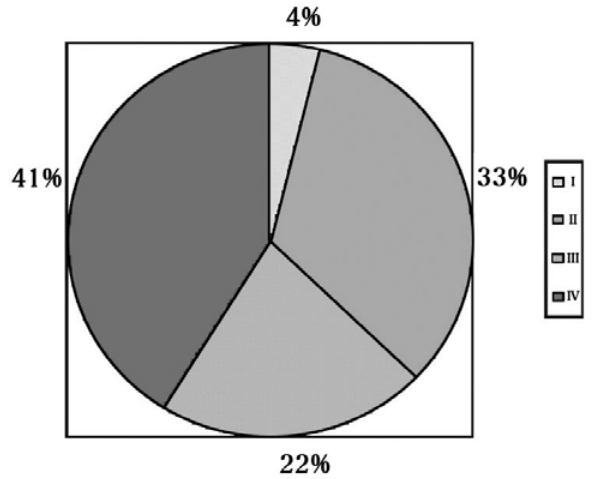
Fig. 1 - Classe funcional pré-operatória